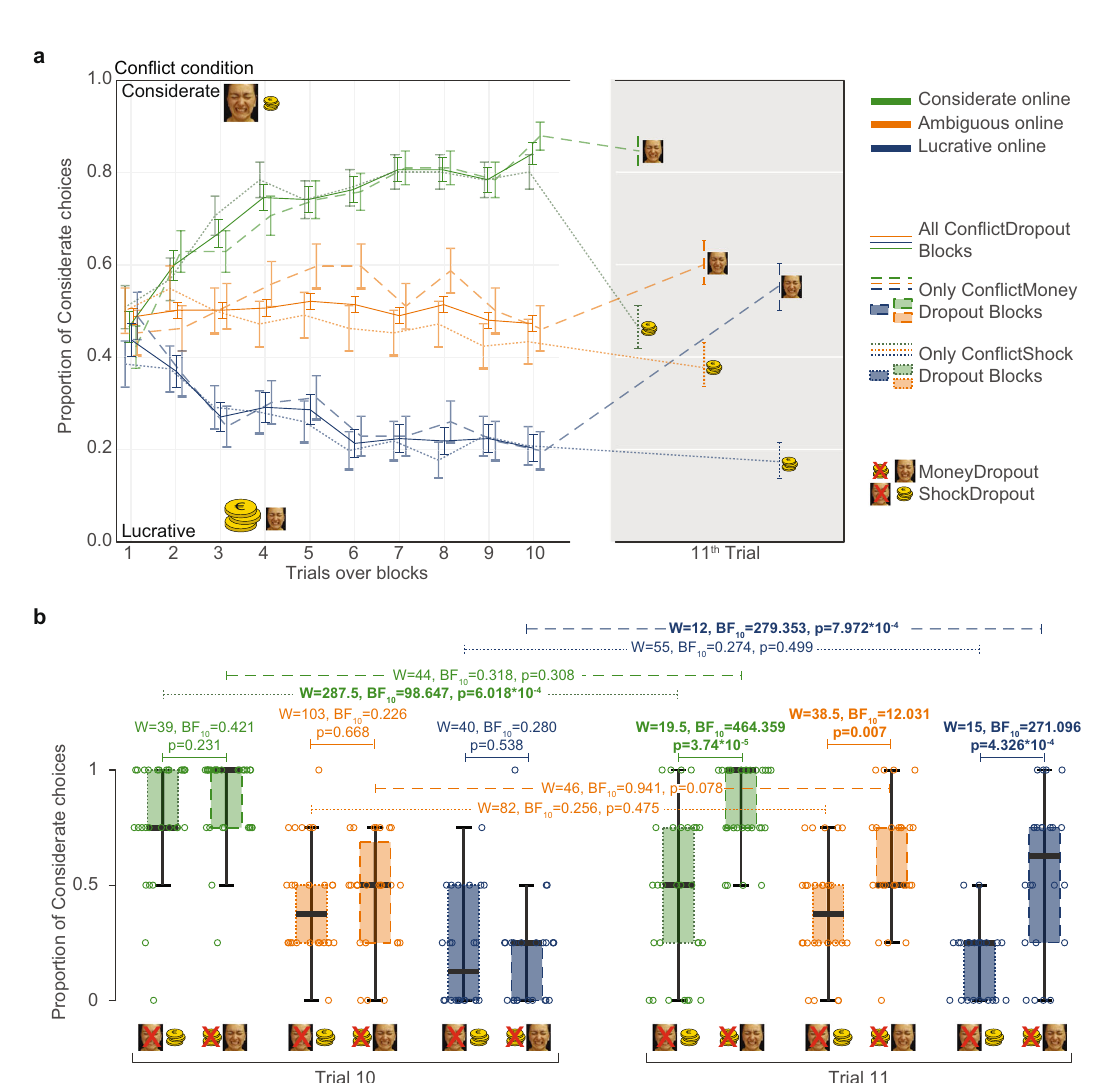
Fig. 3 | Participants ’ report bias. a Participant reports ofperceived high-outcome probability for each symbol in the Con fl ict condition. b Same for the NoCon fl ict conditions. The x axis speci fi es which symbol and the probed question: short/tall pileofmoney=reportedhigh-moneyprobabilityforthesymbolactuallyassociated withlow/high-money;painless/painfulfacereportedhigh-shockprobabilityforthe symbol associated with low/high-shock. As a group, most participants correctly assigned higher probabilities to symbols thathad higher probability, and reported adifferentpatternofprobabilitiesafterCon fl ictandNoCon fl ictblocks.Thickblack lines=average of reported probabilities; dotted black lines=programmed/expec- ted probability. Squarebrackets below the graphs in a and b indicate the direction of thedifferencecomputed in c , d . c Difference between reported probabilitiesfor the low-shock minus high-shock symbol, separately for the Considerate (green), Lucrative (blue) and Ambiguous (orange) preference group, and for the Con fl ict condition. The yellow inlet in the bottom right corner illustrates how the differ- ences in c – e are calculated. Violin plots represent the value distribution, the box- plot within, the median and quartiles, the whiskers, the range of datapoints betweenQ1 – 1.5IQRandQ3+1.5IQR. d SamefortheNoCon fl ictcondition.TheBF10